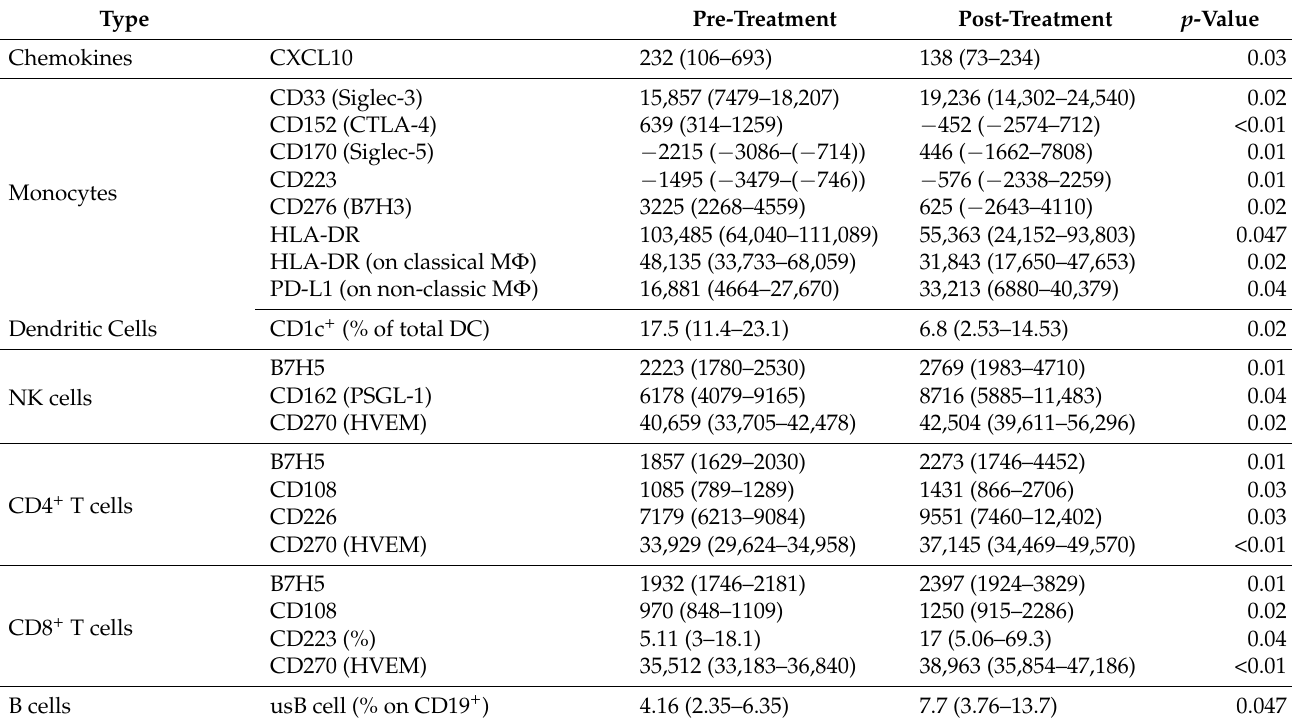
Table 4. Immune parameters and markers before and after treatment with corticosteroids in COVID-19